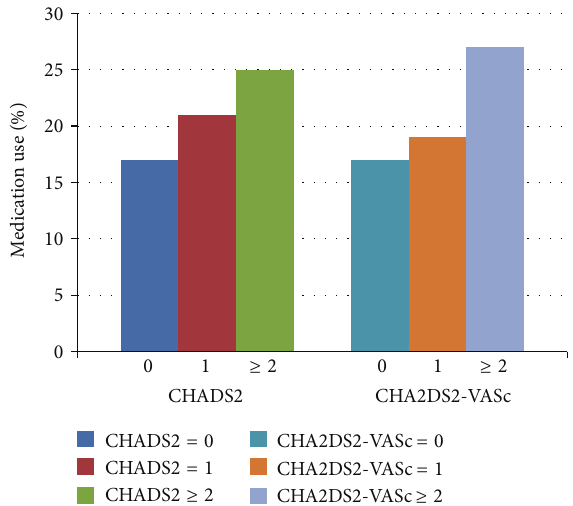
Figure 1: Duke Databank. Warfarin use at discharge following acute myocardial infarction according to CHADS2 and CHA2DS2-VASc scores [24]. Percentages of medication use were visually estimated from primary publication.